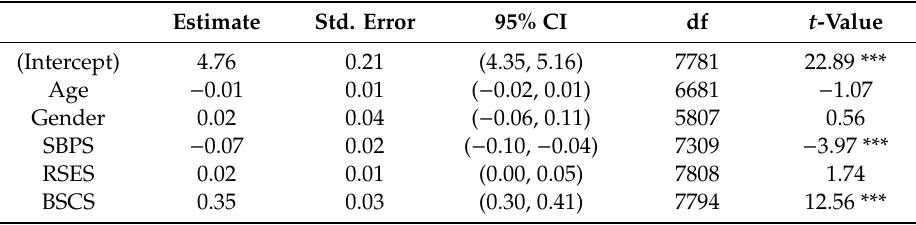
Table 6. Fixed e ff ects from linear mixed e ff ects model predicting